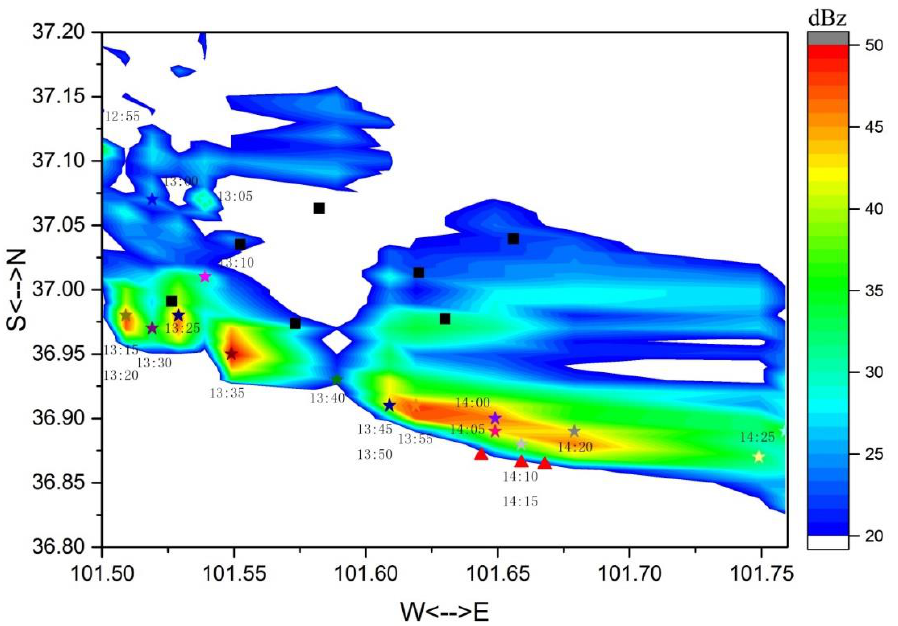
Figure 3. Movement path of the thunderstorm cloud bottom at the height of 2500 m; ⋆ represents the strongest radar echo center position at different times, ■ represents observation sites, and ▲ represents the three villages of hail disaster.